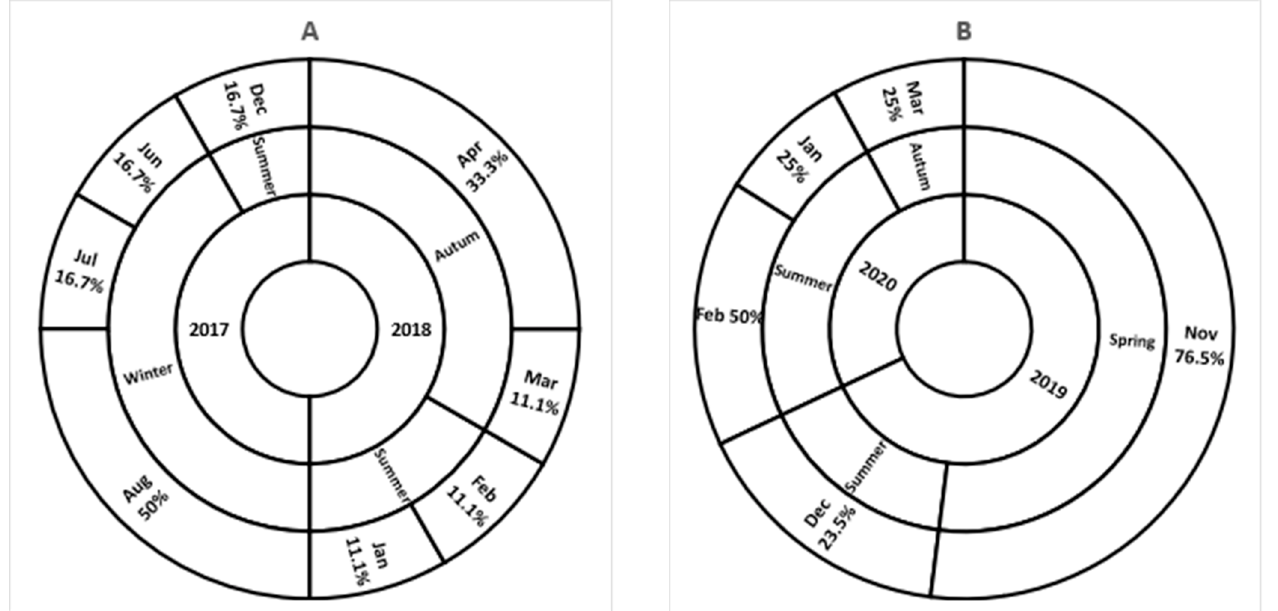
Figure 1. Seasonal distribution of detected SV from 2017 to 2018 ( A ), and from 2019 to 2020 ( B ). Inner circle present a year of sample collection; middle circle present seasons of the year; and the outer circle present the SV detection rate per month.